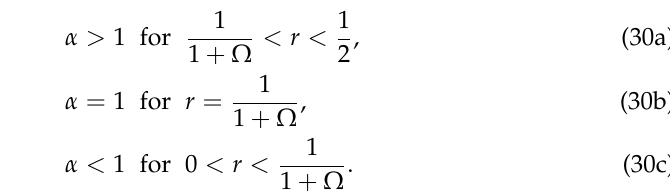
( α < 1, cyan) and the Margolus–Levitin one δ 2 MT